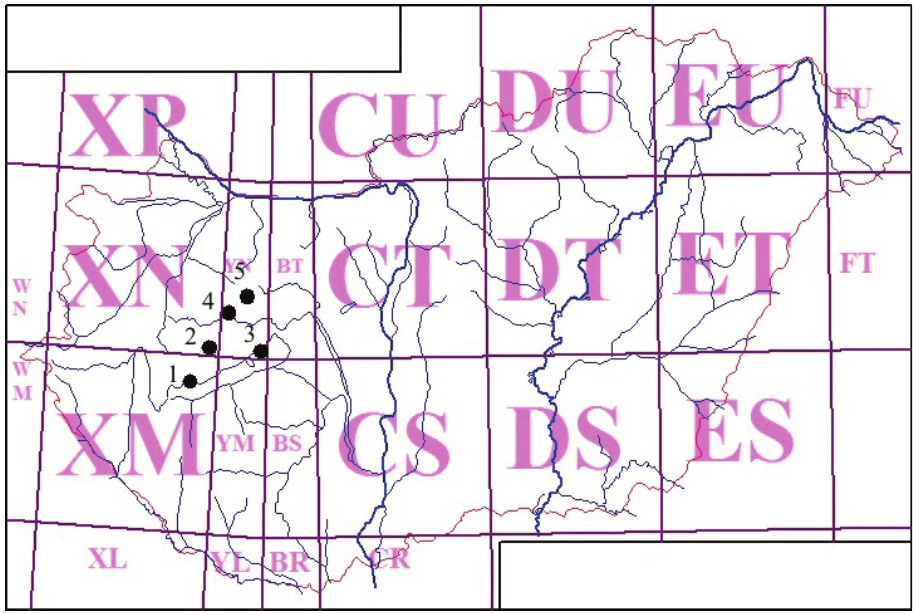
Figure 1. Location on the studied caves in Hungary: 1 Csodabogyós Cave (Balatonederics) 2 Pokol Hole (Kapolcs) 3 Lóczy Cave (Balatonfüred) 4 Kőlik Cave (Szentgál) 5 Takó Cave